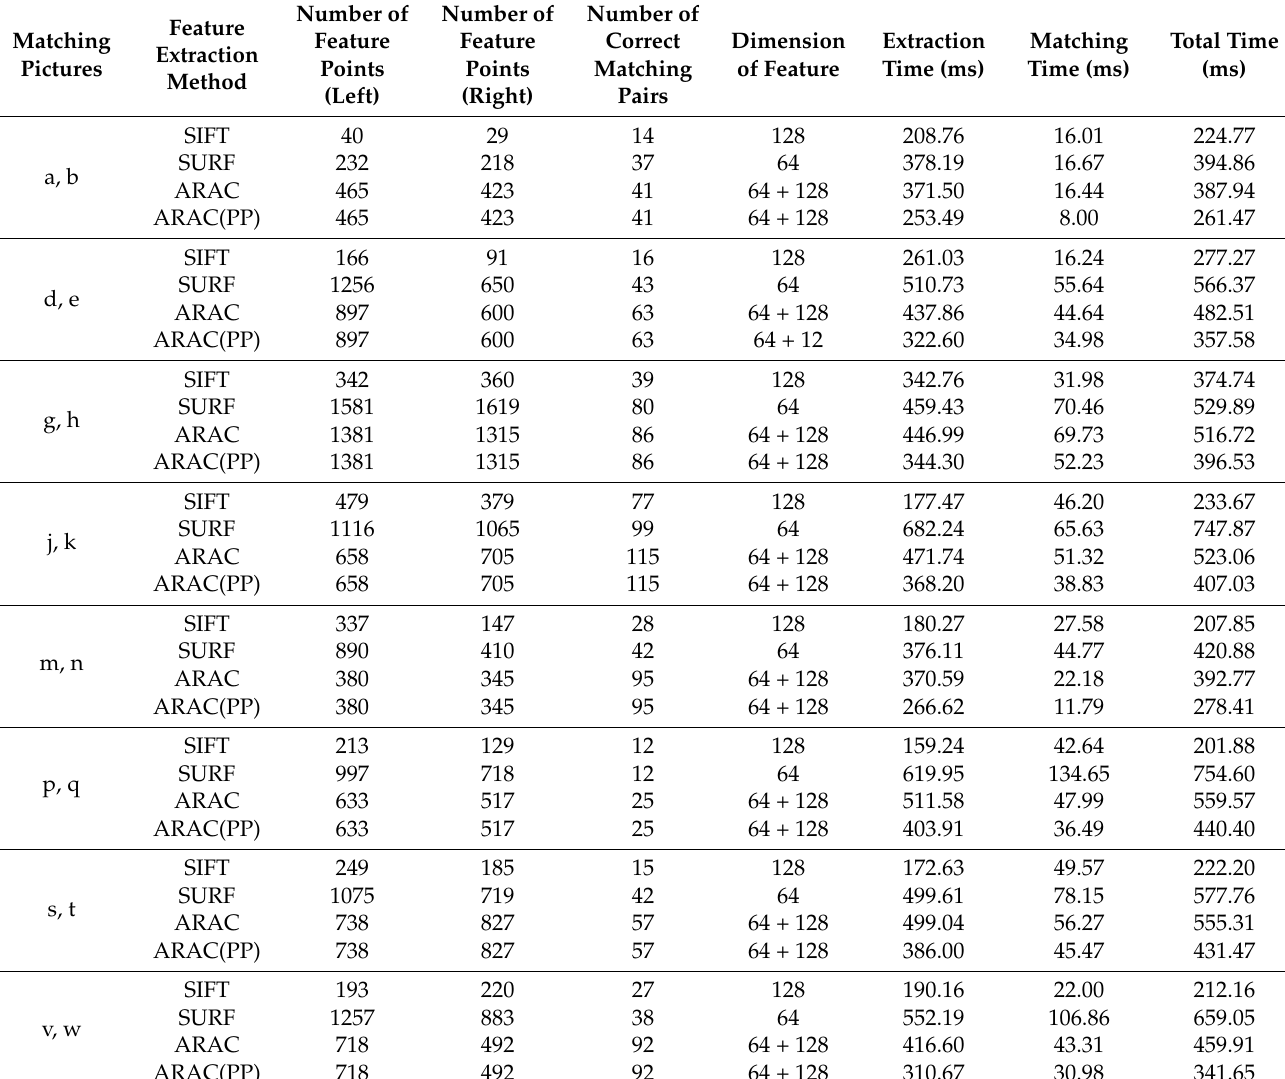
Table 2. Matching results under the condition of illumination change and affine